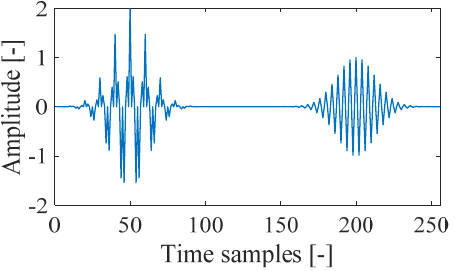
Figure 1. The nonstationary signal composed of three transient Gaussian components.